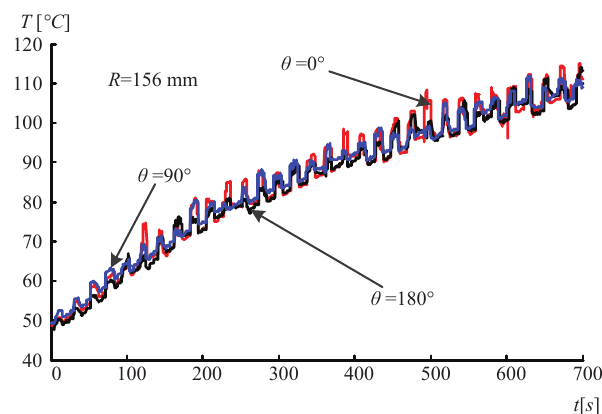
Figure 10. Temperature variation of different points on curve e .